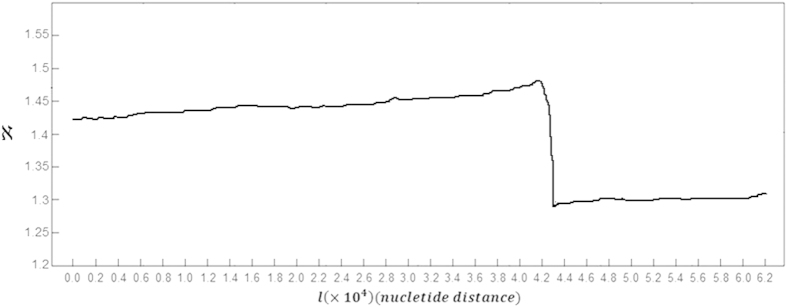
Fractal spectrum plot for the real damaged DNA walk and solution of Equation (13) (after l = 4.2).